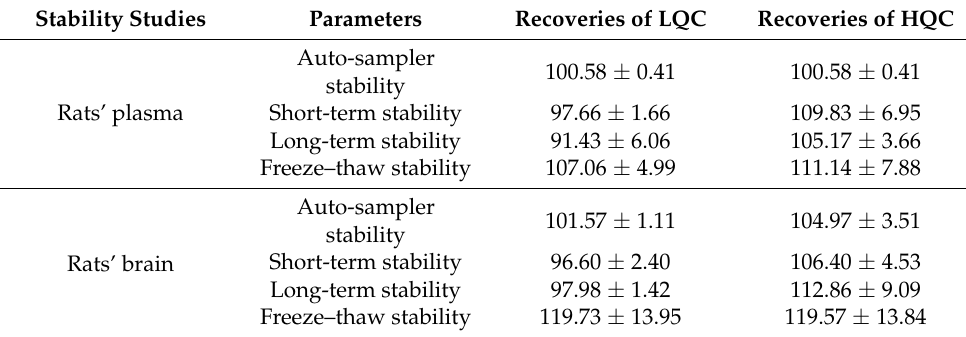
Table 3. Stability studies’ results for OMR determination by the proposed LC-MS/MS Stability